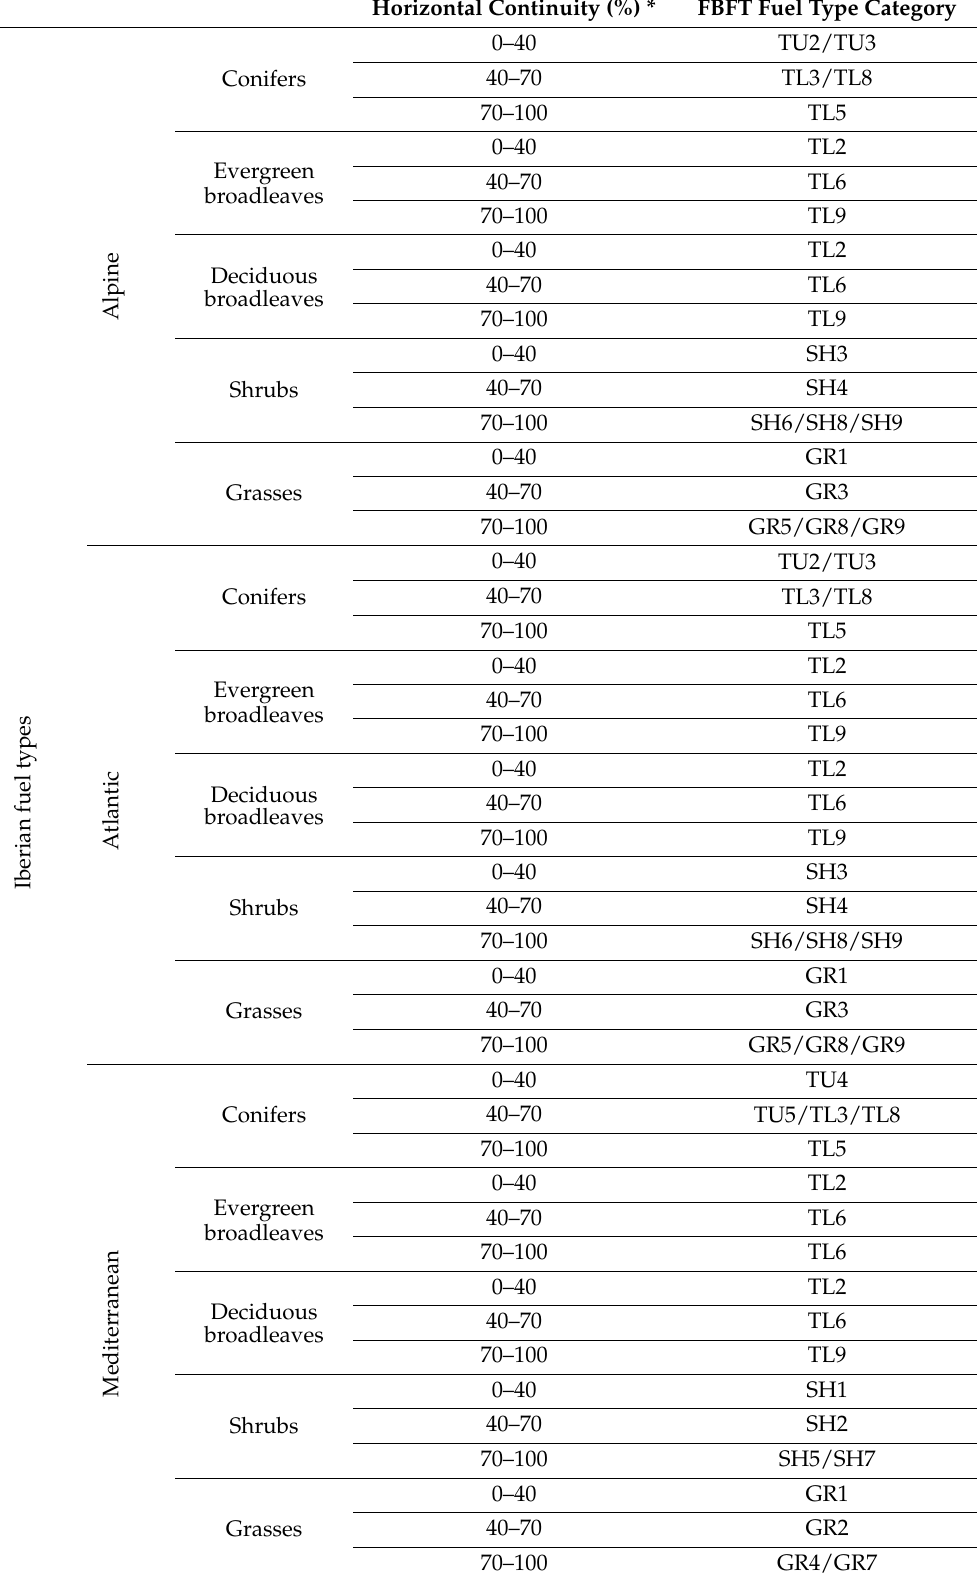
Table 4. Adaptation of the Iberian fuel types to the FBFT system